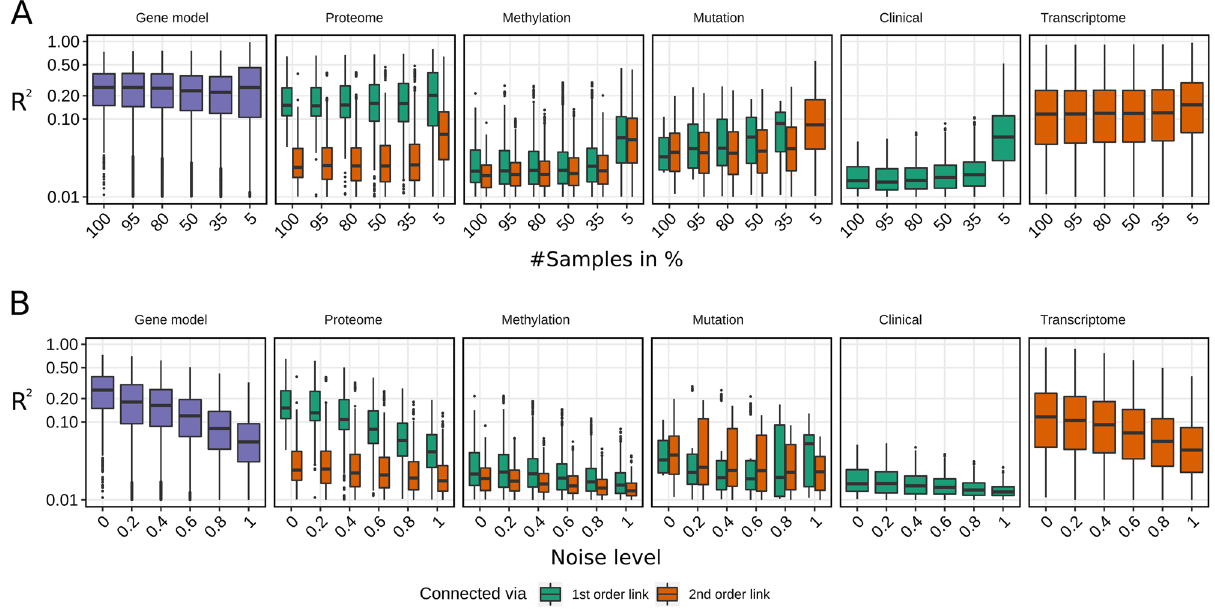
Figure 3. Robustness benchmark for ( A ) different sample sizes and ( B ) noise levels. First set of box plots (purple) shows the overall performance, R 2 (log scaled y axis) of inferred gene models using all available information layers. All following sets describe the stand-alone performances of Proteome, Methylation, Mutation, Clinical and Transcriptomic information layers. 1st order links (green) and 2nd order links (orange) are benchmarked separately. Note, Clinical and Transcriptome information consists of only 1st and 2nd order links. ( A ) Data sets with different sample sizes were generated using 5–100% of the 604 breast invasive carcinoma samples. ( B ) Different test data sets were simulated by adding Gaussian noise with increasing variance to the scaled feature values. Here, the noise level reflects the R 2 for six